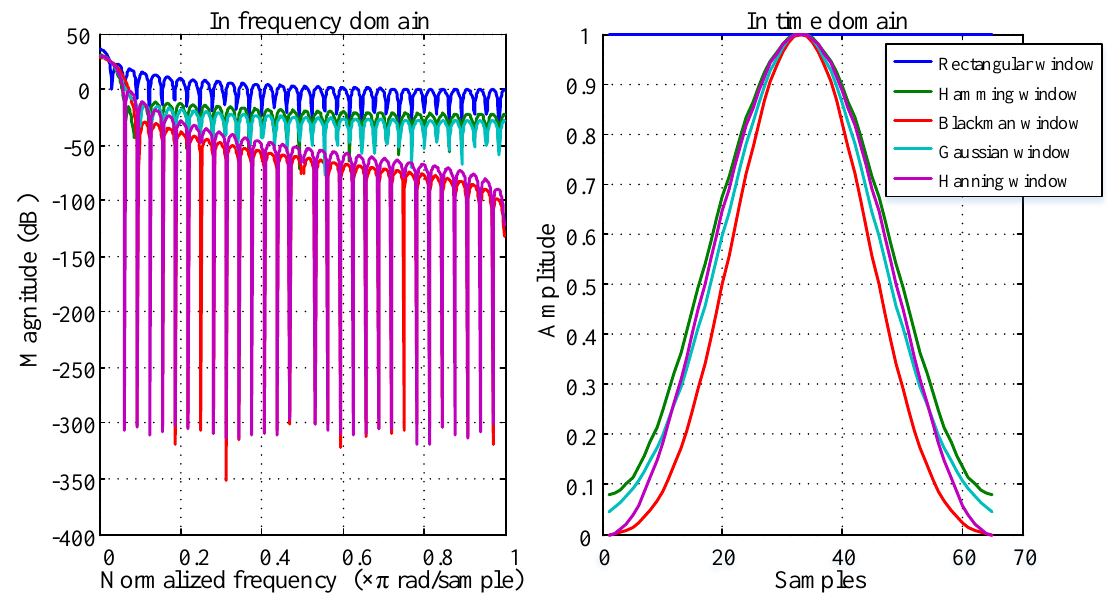
Figure 4. Comparison of several common window functions in the time domain and frequency domain (window length M = 65).